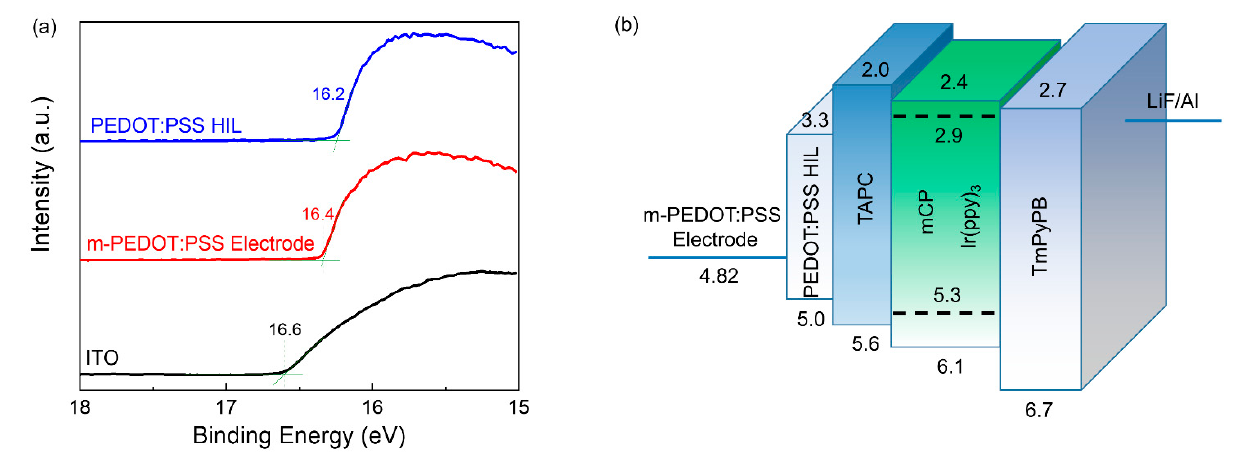
Figure 7. ( a ) The UPS spectra of ITO, PEDOT:PSS electrode, and PEDOT:PSS HIL. ( b ) The energy-level diagrams of the OLEDs.